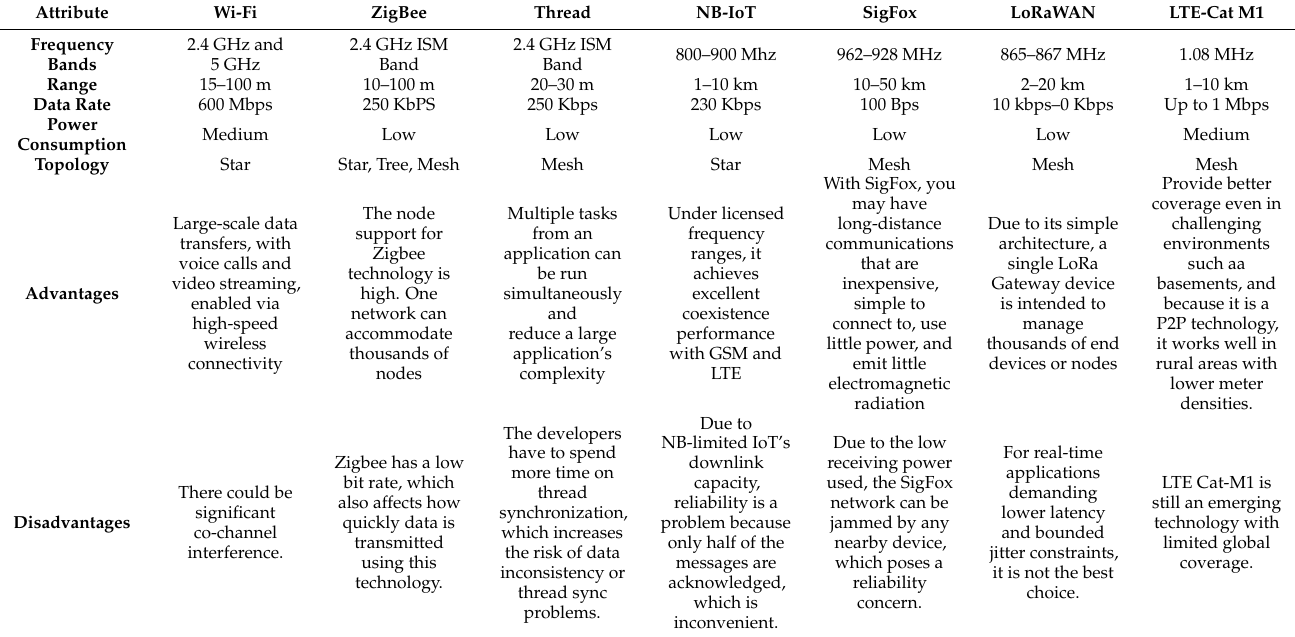
Table 2. Comparison of Various Wireless Technology